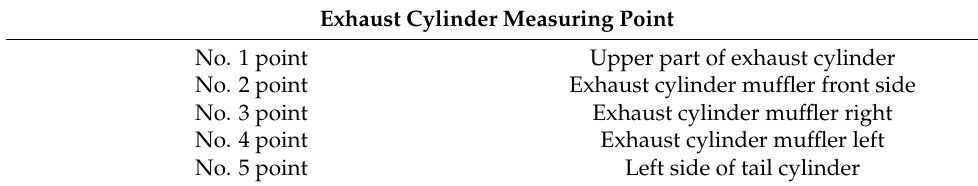
Table 1. Arrangement of measuring points for the tractor exhaust